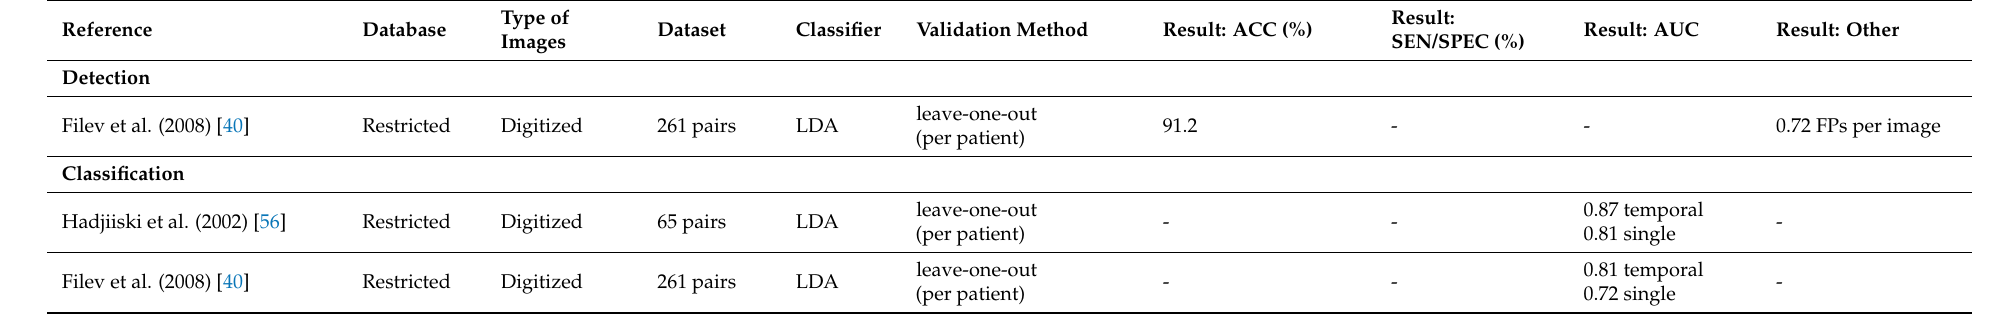
Table 5. Comparison of algorithms for the diagnosis of MCs in sequential mammograms using temporal analysis and feature-based machine